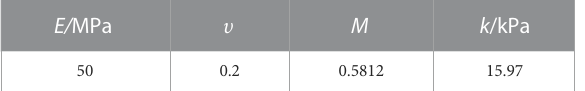
TABLE 3 The calculation parameters of DP